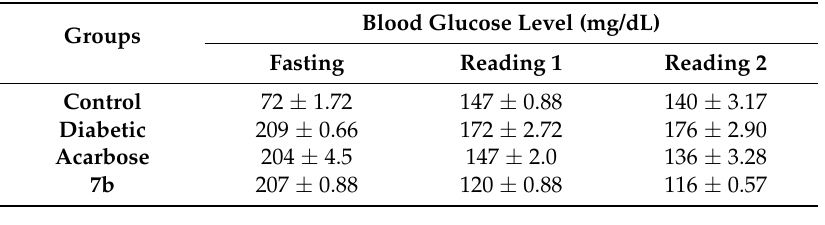
Table 2. In vivo blood glucose data.